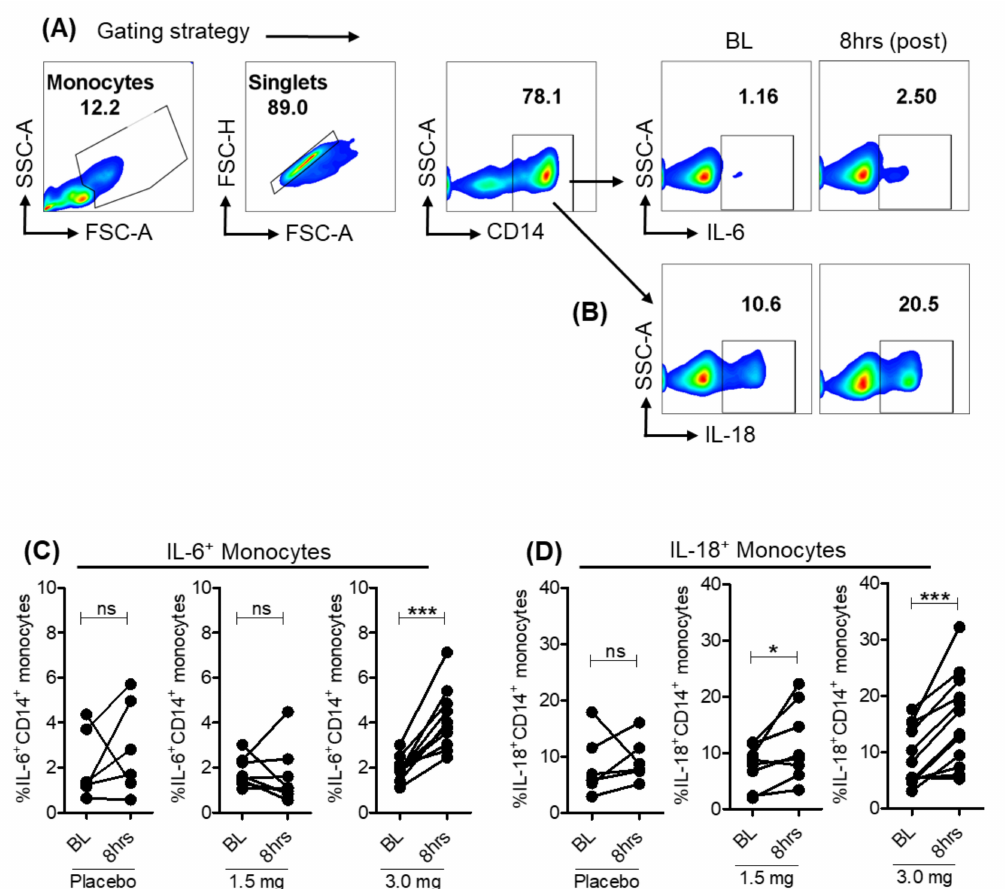
Figure 3. Pro-inflammatory cytokines in monocytes from SLGN-treated individuals. Pseudo color flow plots show gating strategy for measuring ex vivo expression of pro-inflammatory cytokines ( A ) IL-6 and ( B ) IL-18 in CD14 + monocytes. Frequencies of cytokine producing monocytes from baseline and 8-h samples in placebo, 1.5 or 3.0 mg SLGN-treated individuals are presented for ( C ) IL-6 and ( D ) IL-18, respectively. Significance was calculated by a Wilcoxon matched-pairs signed-rank test, and p value ≤ 0.05 * and 0.001 *** show grades of significance. ns: no